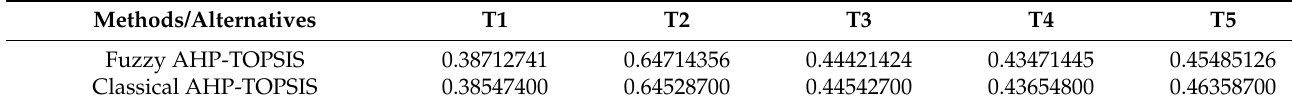
Table 16. Comparison of the AHP-TOPSIS techniques.